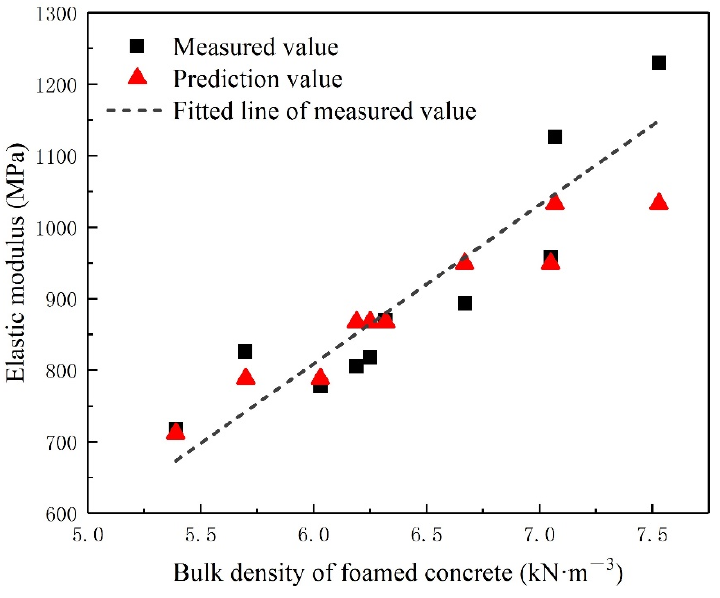
Figure 9. Comparison of elastic modulus test and theory of foamed concrete.